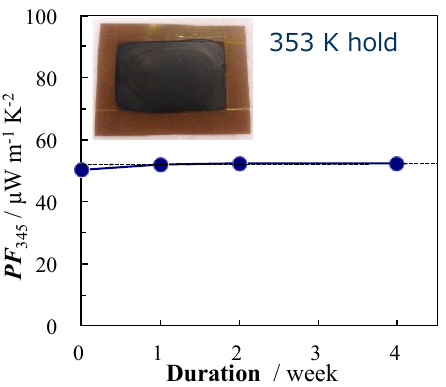
Figure 4. Durability of power factor ( PF ) at 353 K of nano-PETT/PI/SG-CNT hybrid films (film thickness of 3 µm).